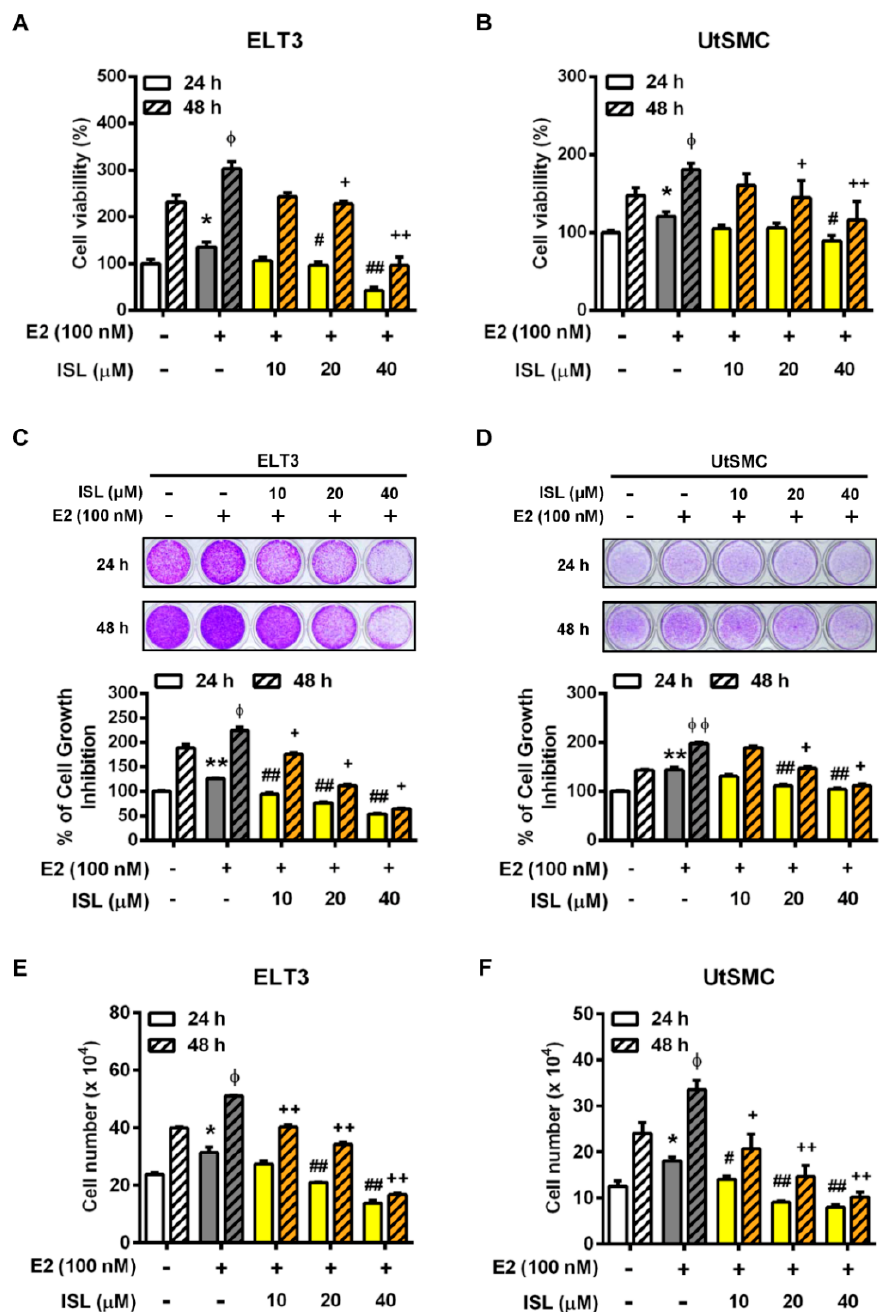
Figure 3. Effects of ISL on the E2-induced cell growth in ELT3 and UtSMC cells. ( A , B ) ELT3 and UtSMC cells were seeded at 3000 cells per well in 96-well plates. Both cell types were treated with E2 (100 nM) alone or E2 plus ISL at 10, 20, or 40 μ M for 24 and 48 h. Cell viability was detected using crystal violet assay ( n = 4). ( C , D ) ELT3 (6 × 10 4 cells per well) and UtSMC (1.5 × 10 5 cells per well) cells were seeded in 6-well plates. Both cell types were treated as indicated above. Cell viability was detected using crystal violet assay ( n = 4). ( E , F ) ELT3 (6 × 10 4 cells per well) and UtSMC (1.5 × 10 5 cells per well) cells were seeded in 6-well plates. Cells were treated as indicated above. Cell numbers were counted using trypan blue stain ( n = 3). Data are represented as means ± SEM. * p < 0.05, ** p < 0.01 as compared with the 24 h-control group. ϕ p < 0.05, ϕϕ p < 0.01 compared with the 48 h-control group. # p < 0.05, ## p < 0.01 compared with the 24 h E2-treated group. + p < 0.05, ++ p < 0.01 compared with the 48 h E2-treated group.